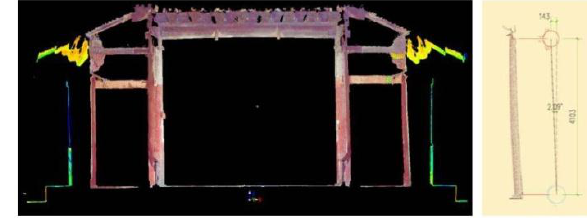
Figure 19 3-D point cloud section of the Main Hall